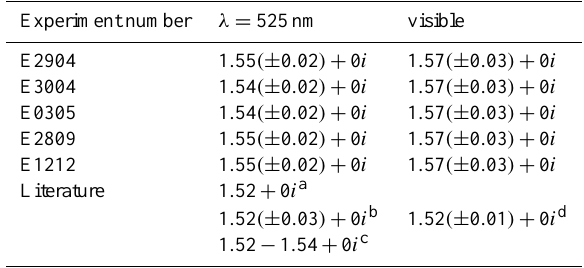
Table 2. Retrieved RI of dry ammonium sulfate particles for λ = 525nm and in the visible.